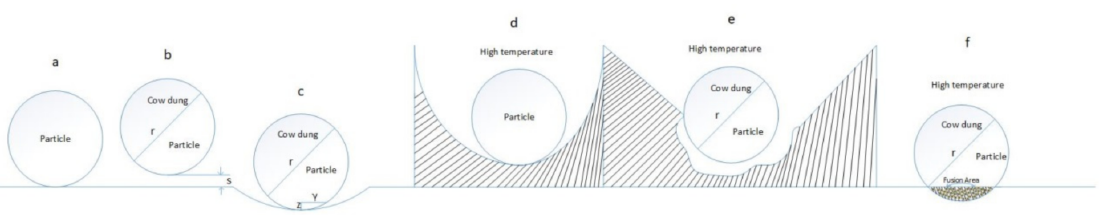
Figure 11. Schematic diagram of van der Waals force during coating